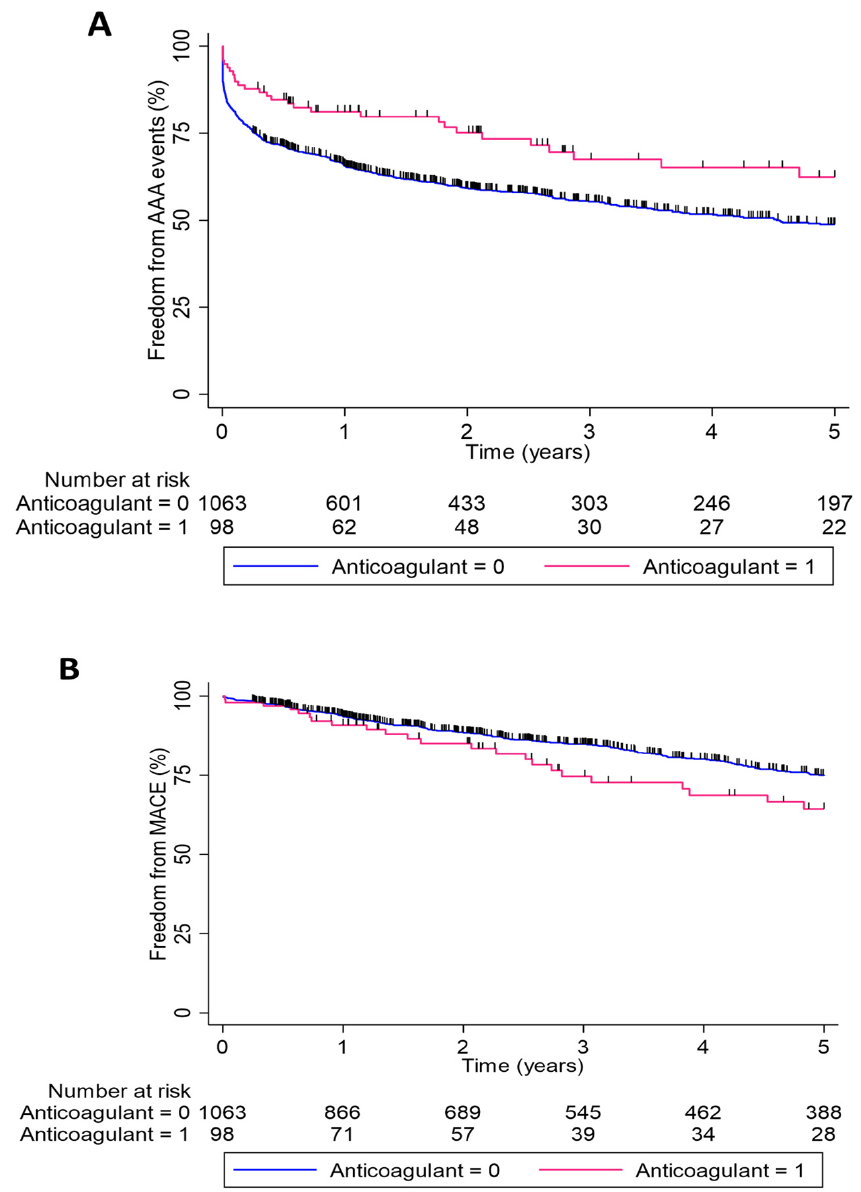
Figure 1. Freedom from AAA repair or mortality due to AAA rupture (AAA events; ( A )) and major adverse cardiovascular events (MACE; ( B )) in patients prescribed anticoagulation (pink line) and those not prescribed these mediations (blue line). Table 2. Association of anticoagulant prescription with AAA-related